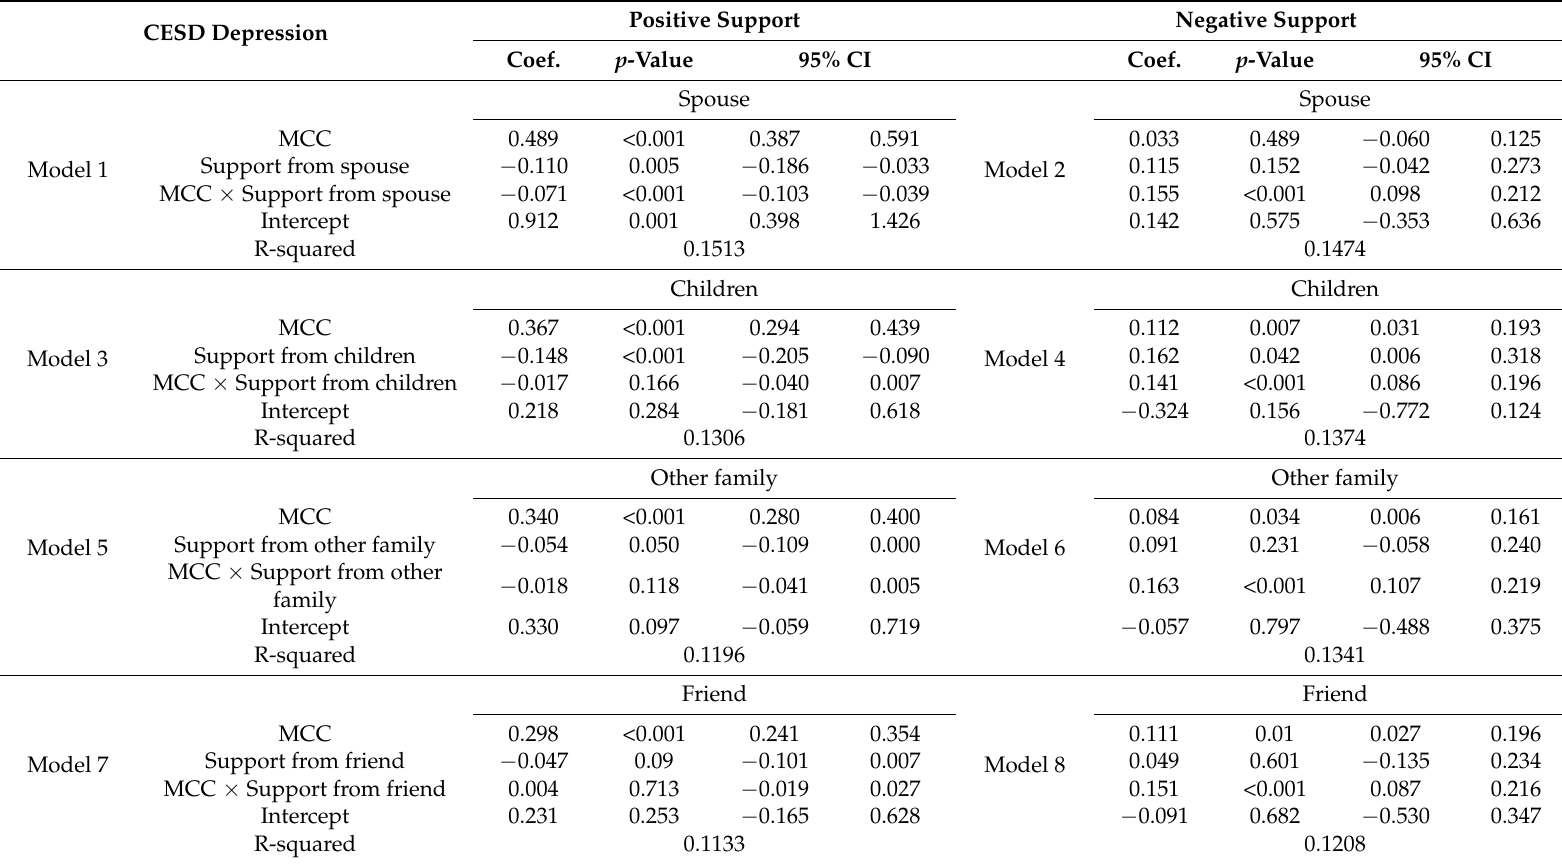
Table 2. Adjusted moderating effect of social support on the association between Multiple Chronic Conditions (MCC) and CESD depression. Positive Support Negative Support CESD Depression Coef.